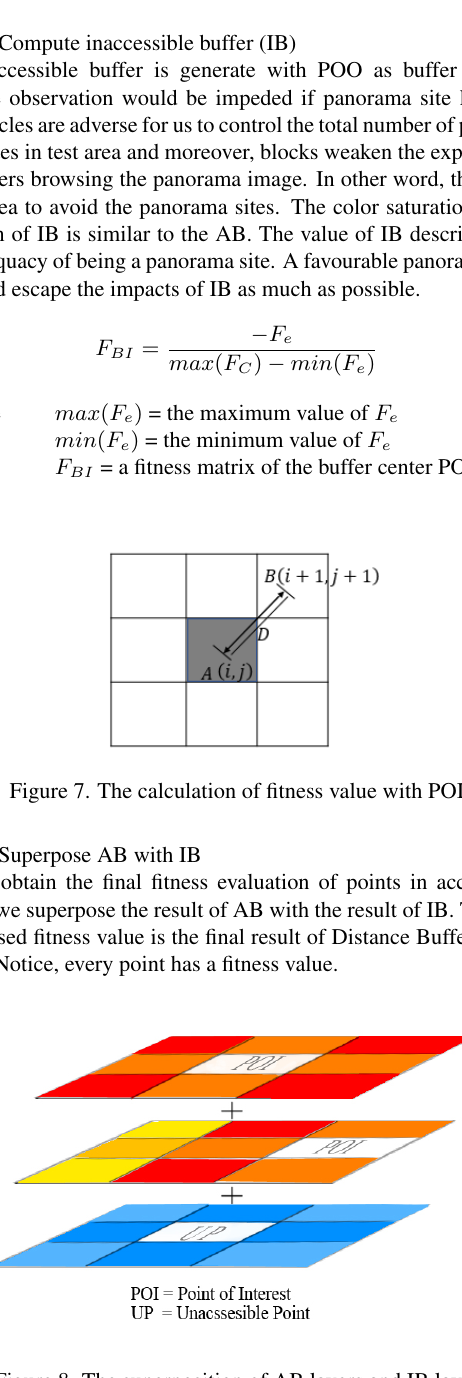
Figure 8. The superposition of AB layers and IB